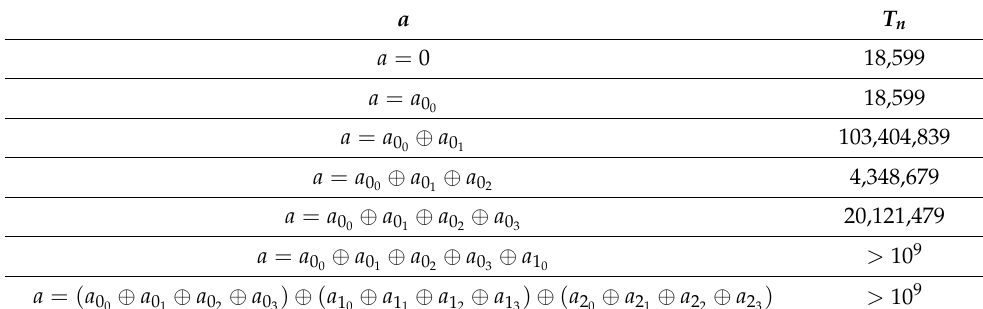
Table 1. Dependence T n on output signal a of the logical scheme LS, q =